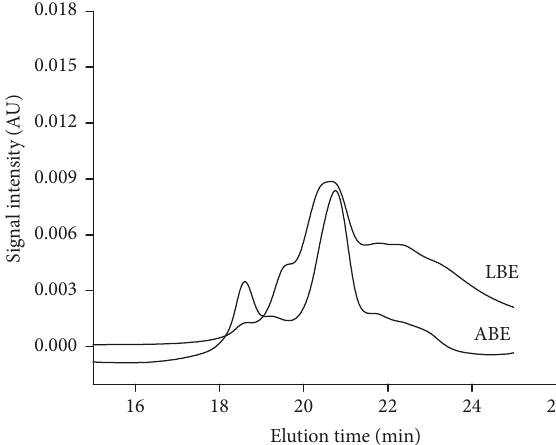
Figure 3: GPC chromatogram of PAs from ABE and LBE.